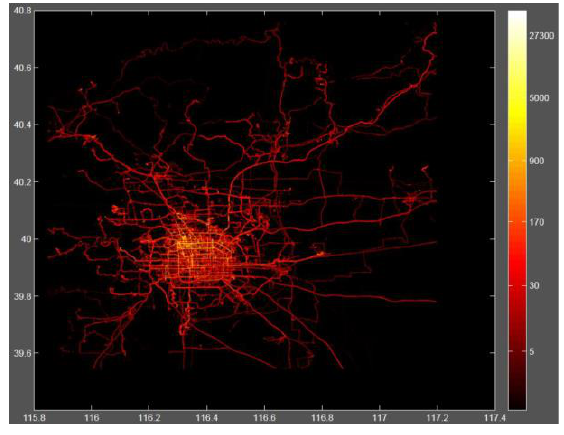
Figure 7. Database distribution in Beijing, China